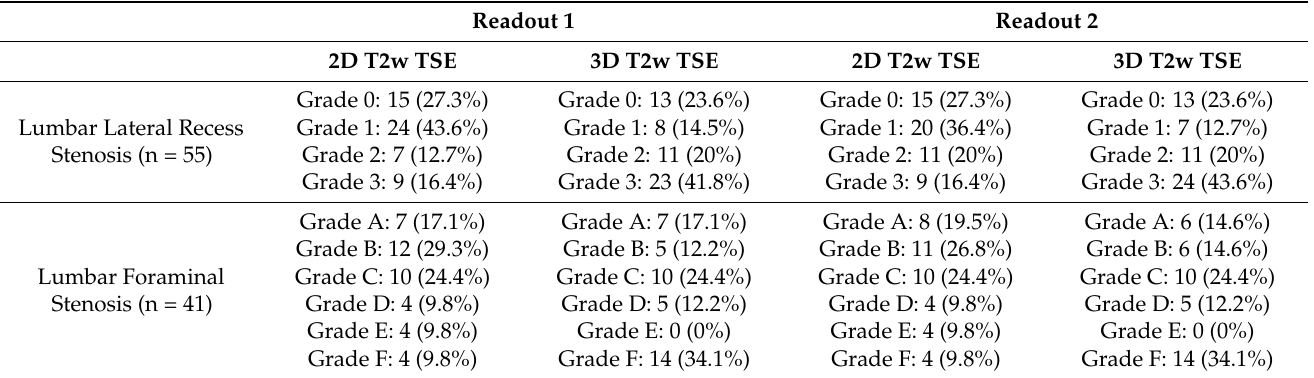
Figure 1. Stacked barplots for the visualization of grading scores stratified by readout and sequence. ( A ) shows the scores for the grading of lumbar lateral recess stenosis and ( B ) shows the grading of lumbar foraminal stenosis. Note the shift toward higher grade stenosis on 3D imaging. Table 1. Overview of grading scores. For the sake of clarity, only the simplified grading scores from lumbar foraminal stenosis are shown.